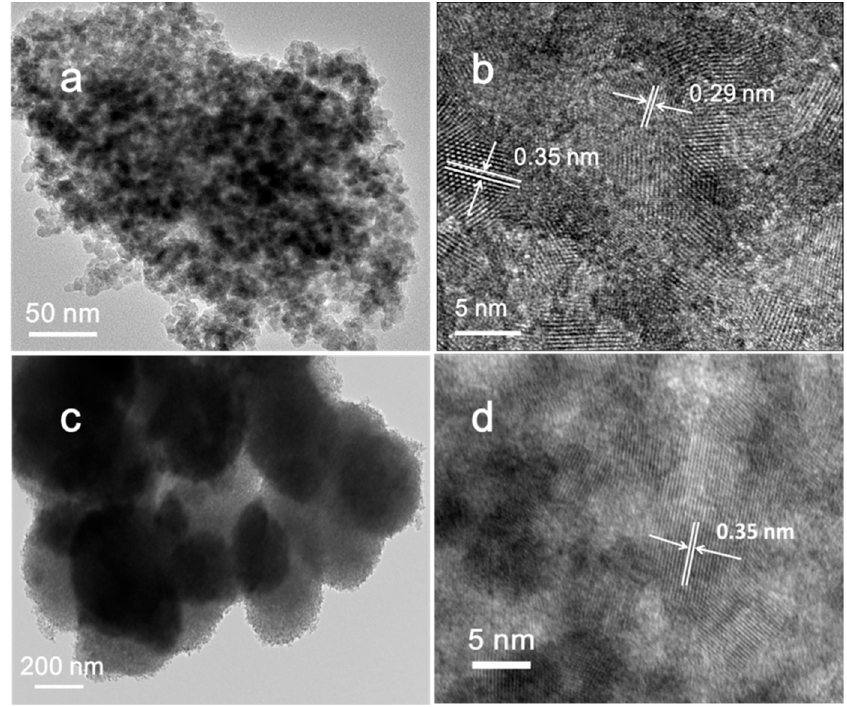
Figure 4. ( a ) TEM and ( b ) HTEM images of MTiO 2 /DDA. ( c ) TEM and ( d ) HTEM images of MTiO 2 /Ala.